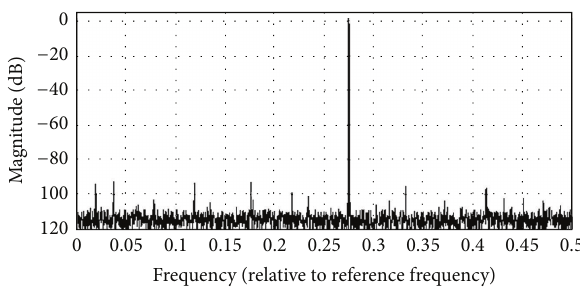
Figure 15: Calculated output